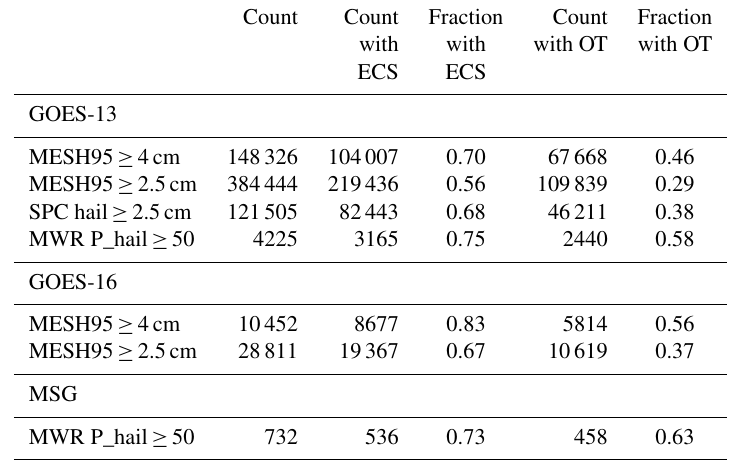
Table A1. Detection counts and fractions of geostationary-derived embedded cold spot (ECS) and OT detections matched within 28km 2 and 15min of hail observations.